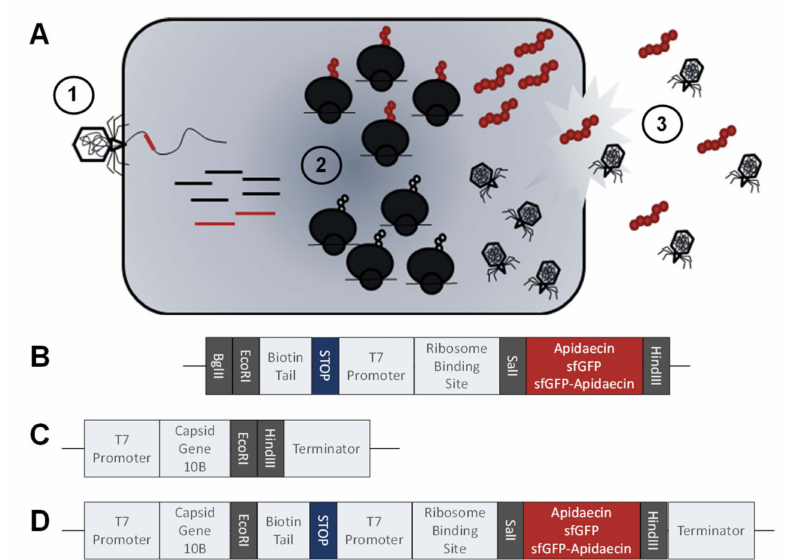
Figure 1. ( A ) Schematic illustration of an E. coli cell infected by an engineered phage also encoding an AMP. 1 (cid:13) Injection of the phage genome; 2 (cid:13) Phage replication and induction of AMP production; 3 (cid:13) Spread of phages and AMP by bacteria lyses; ( B ) DNA fragment encoding for apidaecin, sfGFP, or sfGFP-apidaecin fusion protein; and ( C ) genome of T7Select TM 415 showing region of 10B capsid protein and cloning site; ( D ) Both constructs were used for cloning and integration in the genome of an engineered bacteriophage triggering the expression for apidaecin, sfGFP, or sfGFP-apidaecin fusion protein in the infected E. coli